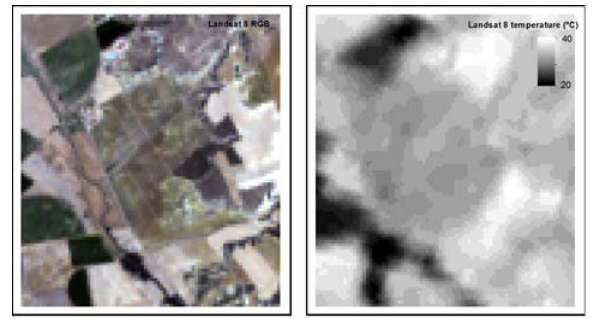
Figure 4. Left, Landsat 8 RGB composite. Right, Landsat 8